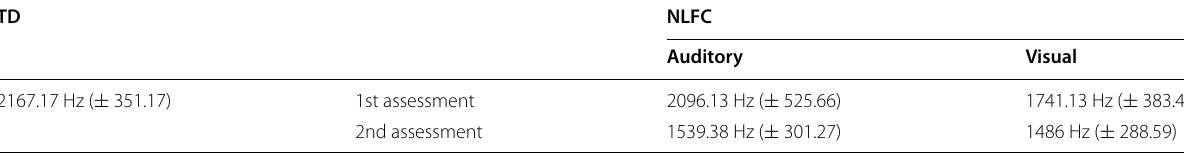
Table 2 F2 of sustained [a] vowel in TD and NLFC